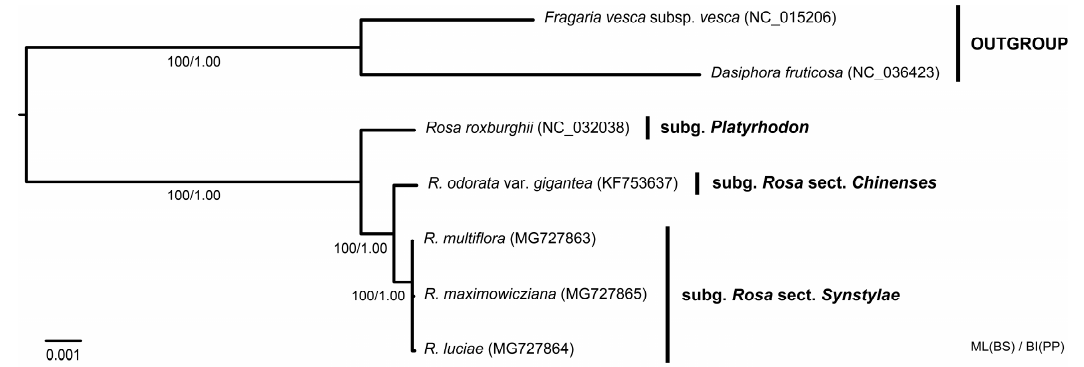
Figure 8. Phylogenetic tree of five Rosa chloroplast genomes inferred from maximum likelihood (ML) and Bayesian Inference (BI) based on whole chloroplast genome data. Bootstrap values (BS) from ML analysis and posterior probabilities (PP) from BI were annotated at each branch.